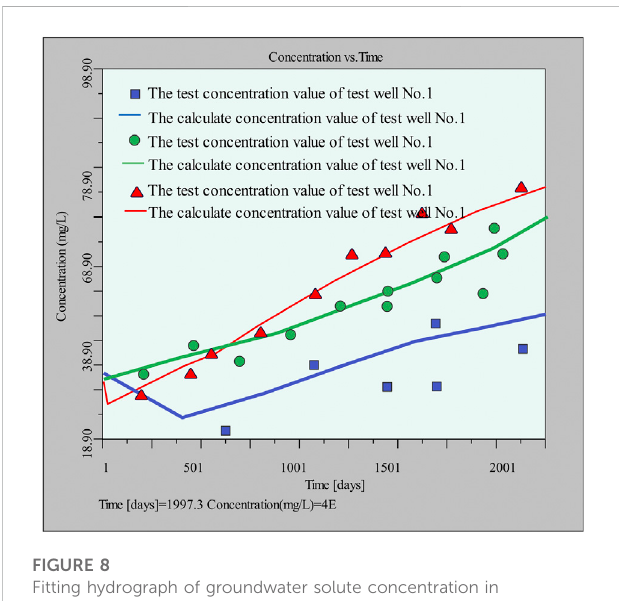
FIGURE 8 Fitting hydrograph of groundwater solute concentration in calibration monitoring